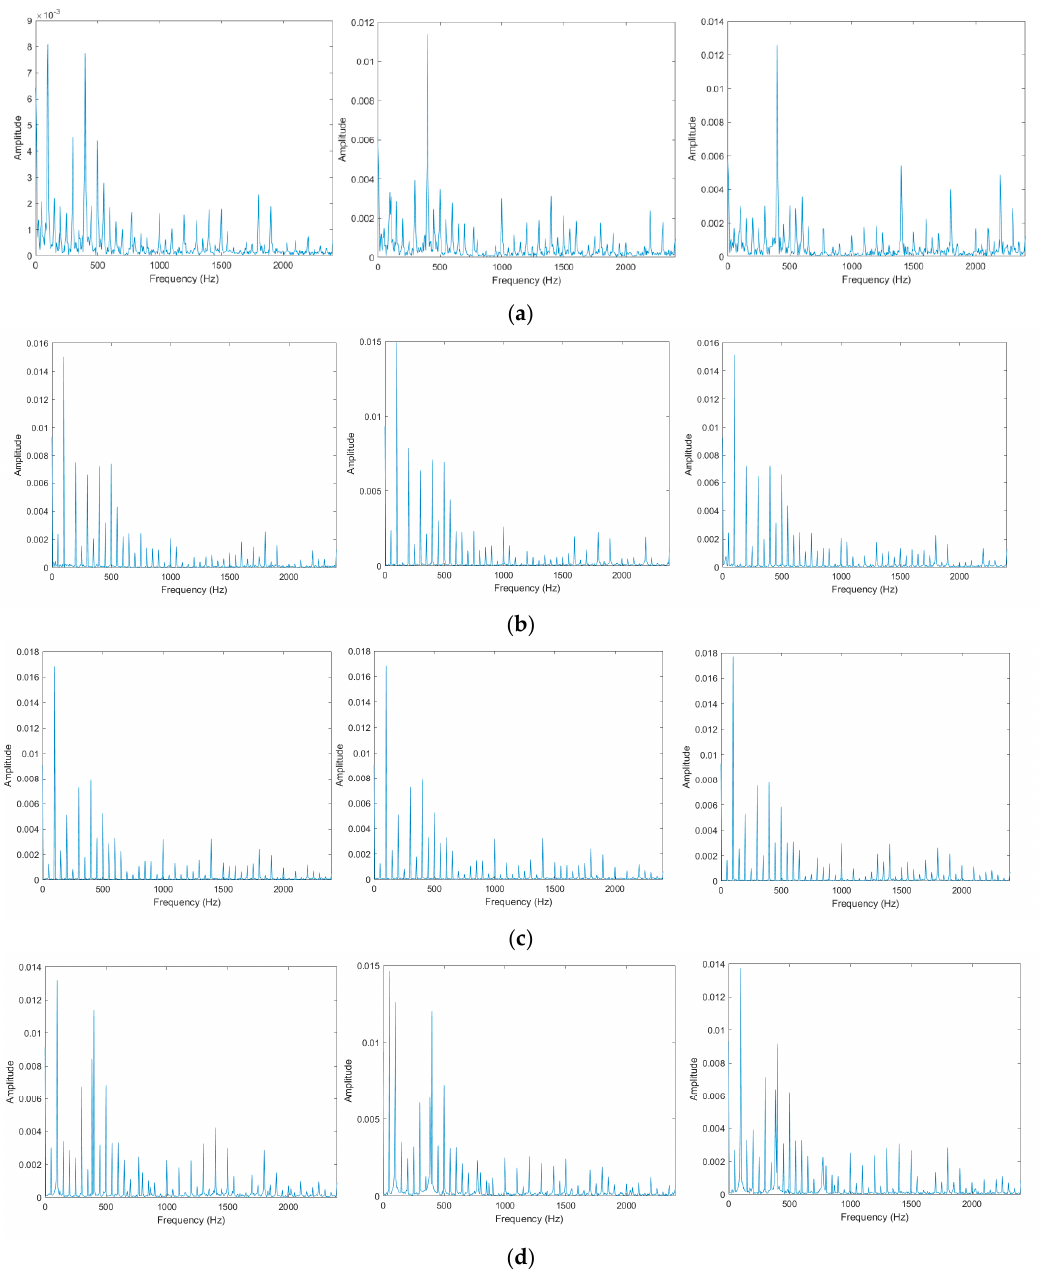
Figure 3. Frequency domain characteristic diagram of transformer vibration. ( a ) Spectrum during harmonic current operation. ( b ) Spectrum during light load operation. ( c ) Spectrum during heavy load operation. ( d ) Spectrum during three − phase unbalance operation.